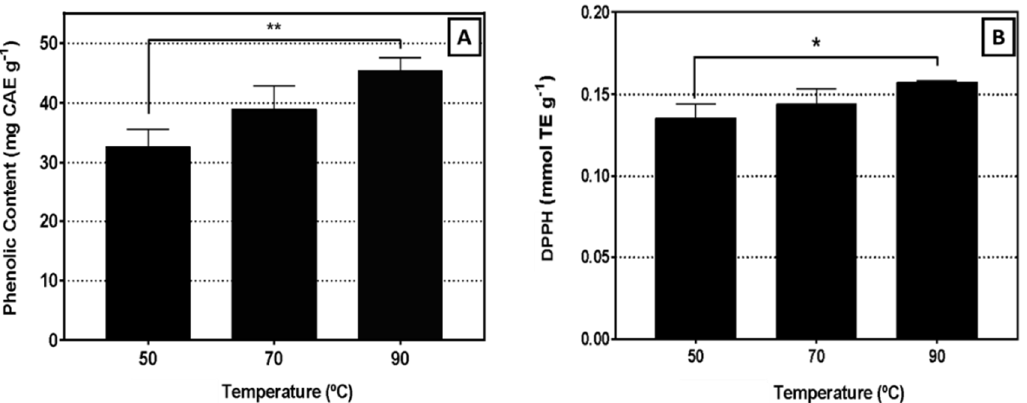
Figure 1. Phenolic content ( A ) and radical scavenging activity (DPPH) ( B ) of Sambucus nigra L. flower aqueous extracts at different extraction temperatures. Values are the mean of three independent experiments ± SD. * p < 0.05, ** p <